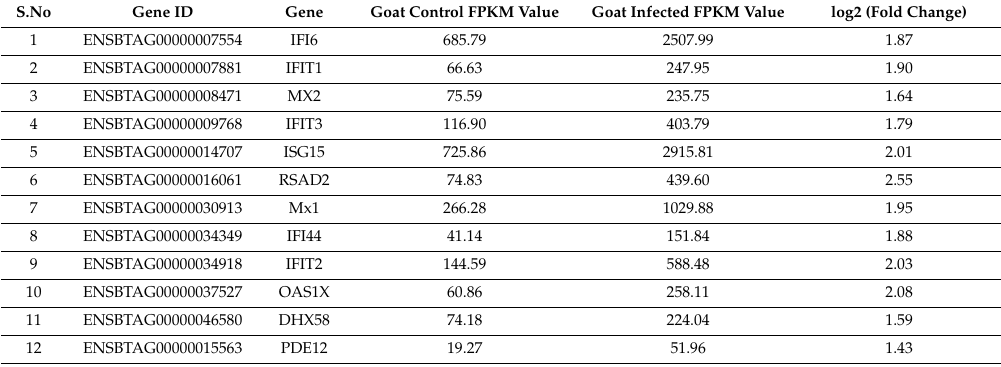
Table 5. The selected di ff erentially expressed transcripts playing a role in innate immune response and host defense to virus in the Control vs. PPRV infected (Goat